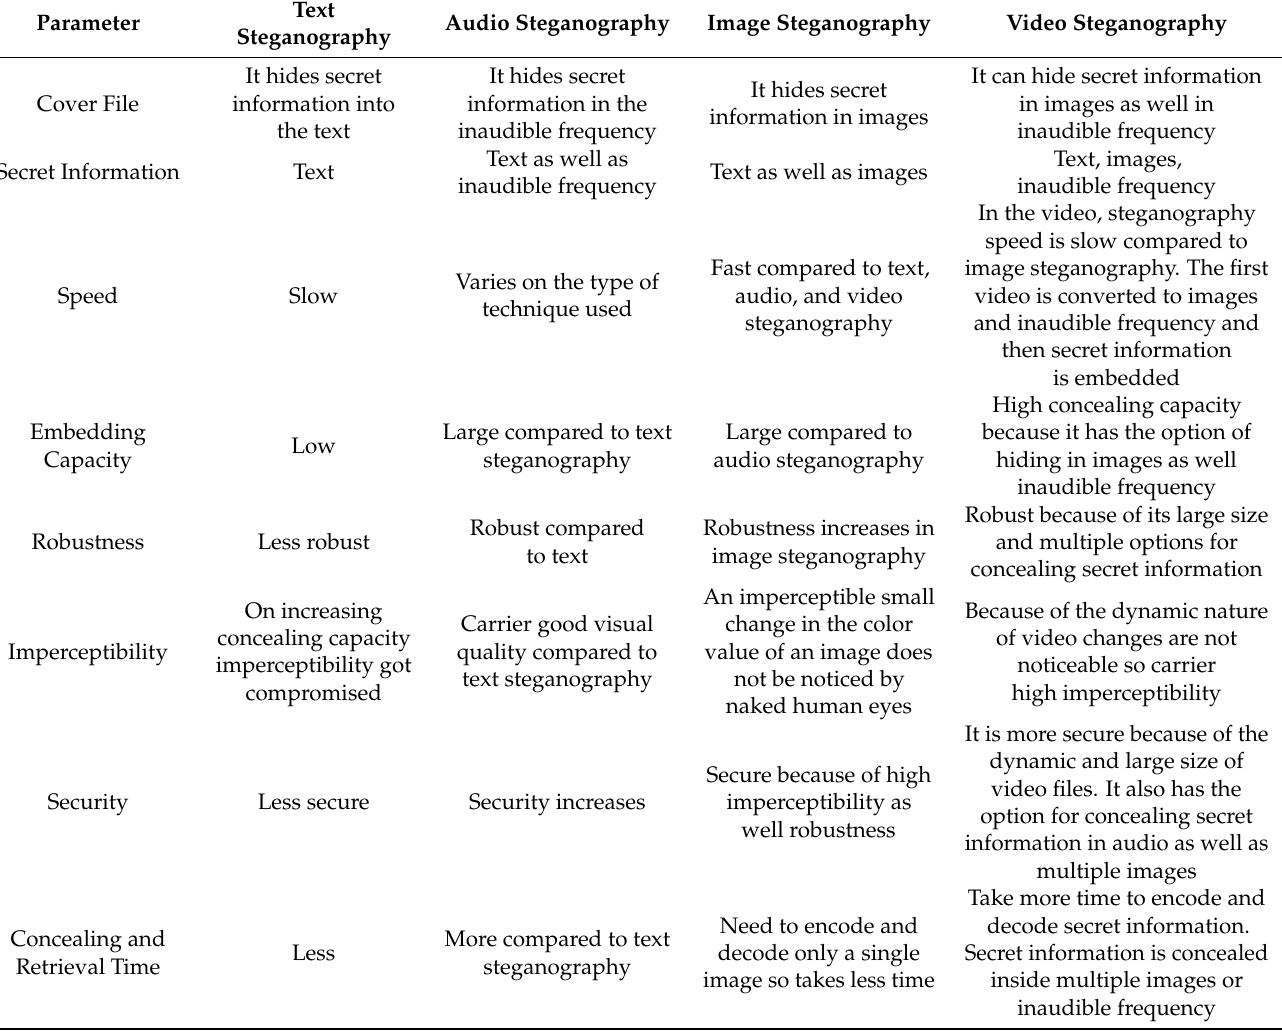
Table 1. Steganography Techniques based on Cover File Type